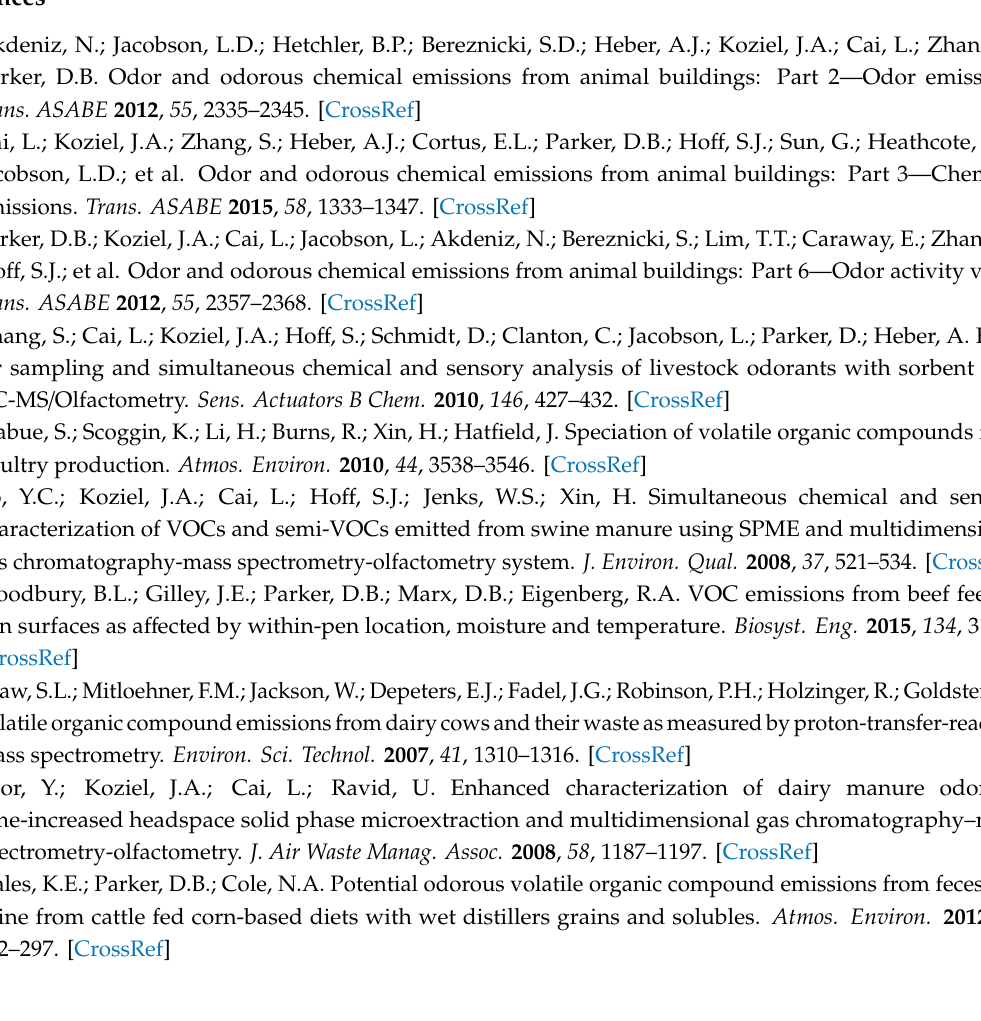
Table S3: UV 254 + TiO 2 : summary of mass removal rates, measured gas concentrations in UV-treated gas, and percent VOC reduction. Table S4: UV 254 : summary of mass removal rates, measured gas concentrations in UV-treated gas, and percent VOC reduction. Table S5: UV 254 + 185 + TiO 2 . Linearity of percent conversion (y) and measured light energy (x) dosage at 254 nm. Table S6: Reproducibility of the e ff ect of light energy dose on UV treatment: ranges of RSDs (%). Table S7: Reproducibility of the e ff ect of relative humidity on UV treatment: ranges of RSDs (%). Table S8: Reproducibility of the e ff ect of temperature on UV treatment: ranges of RSDs